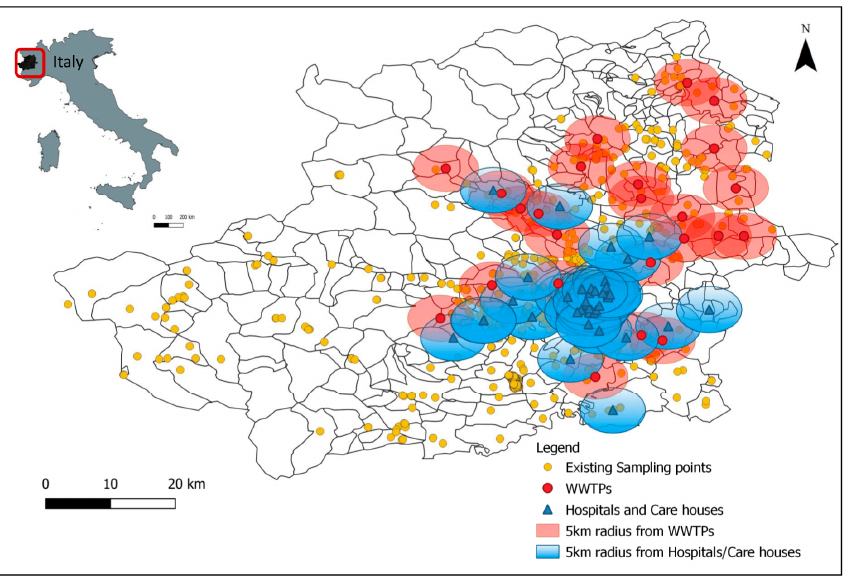
Figure 1. Map of the study area and its geographical position in the Italian territory, including all SMAT existing sampling points in the catchment areas, WWTPs, hospitals/care houses taken into account as potential pollution sources.